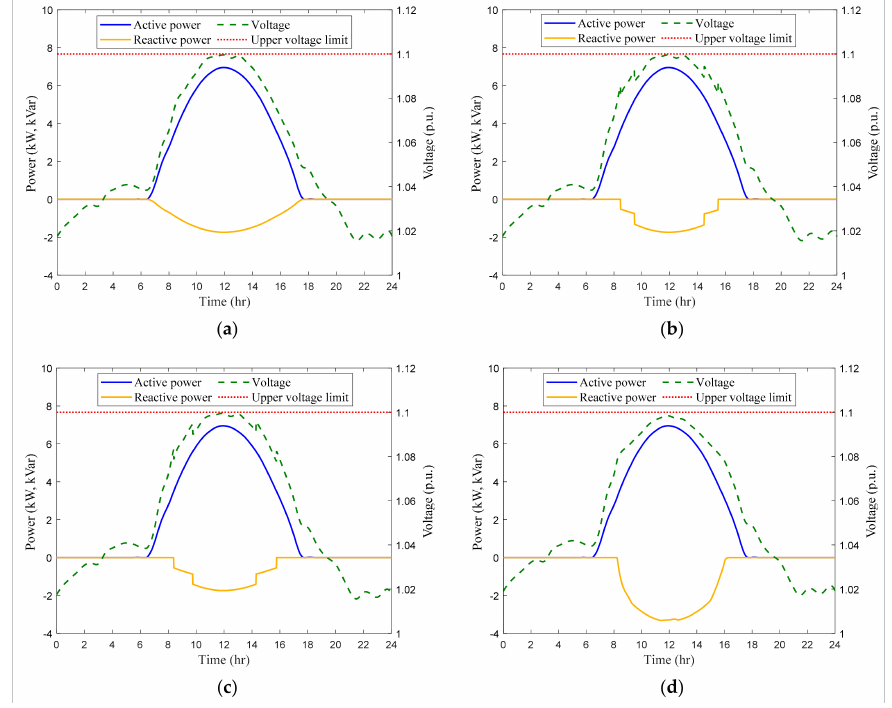
Figure 11. Daily variations of the terminal voltage and active and reactive power output of the PV inverter connected to the critical node with ( a ) the fixed PFC, ( b ) scheduled PFC, ( c ) PFC as a function of injected active power, and ( d ) Volt-Var